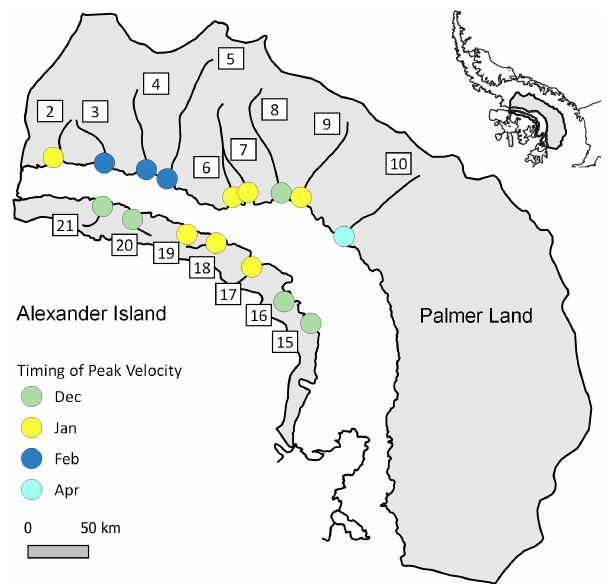
Figure 6. Month of maximum velocity obtained from the detrended SAR-derived observations shown in Fig. 5. Inset map shows the location of GVIIS’ drainage